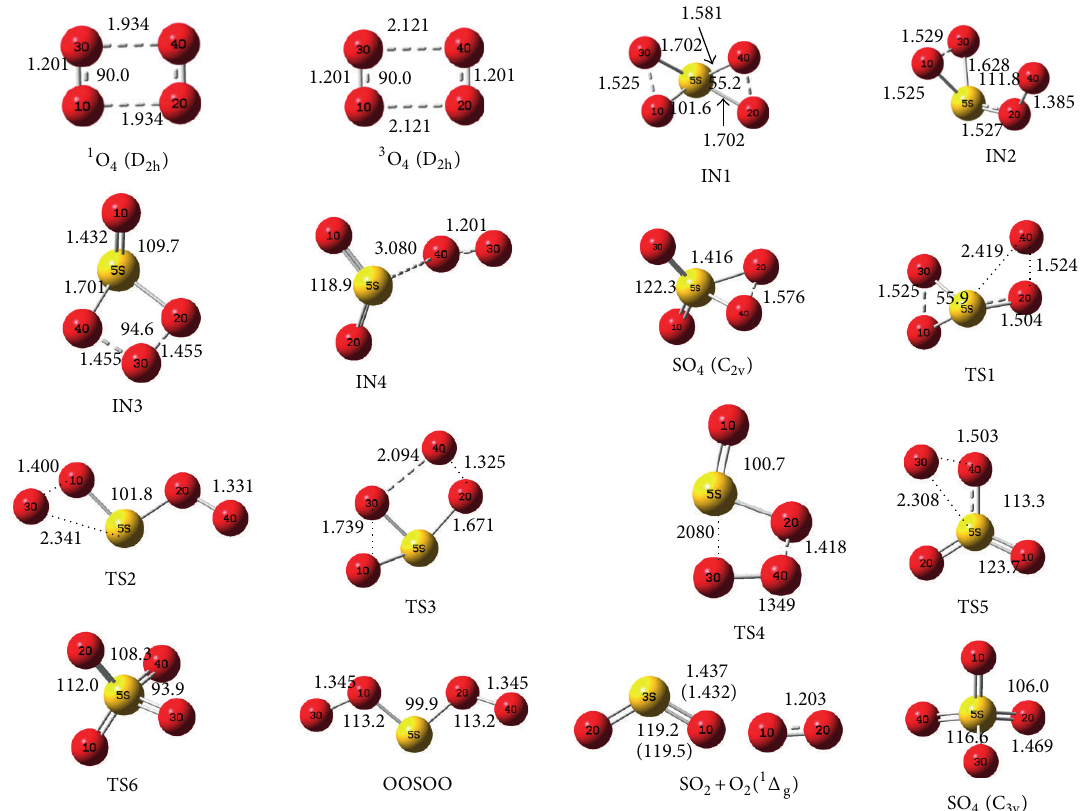
Figure 1: Geometries of reactants, products, intermediates, and transition states optimized on the singlet PES at the B3LYP level (bond distances are in angstrom and angles are in degree). The values in parentheses refer to experimental data [35].